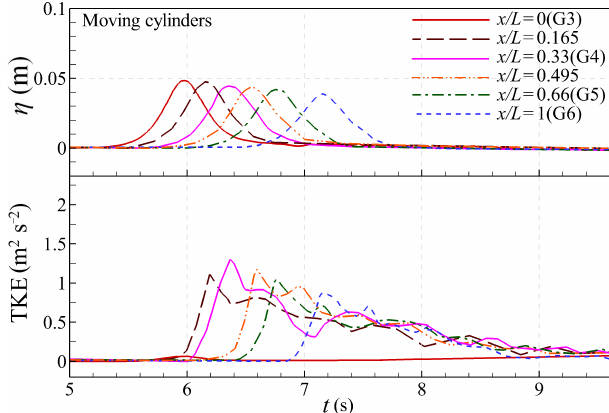
Figure 14. The time evolution of surface elevation and TKE at each section for moving cylinders, H i =